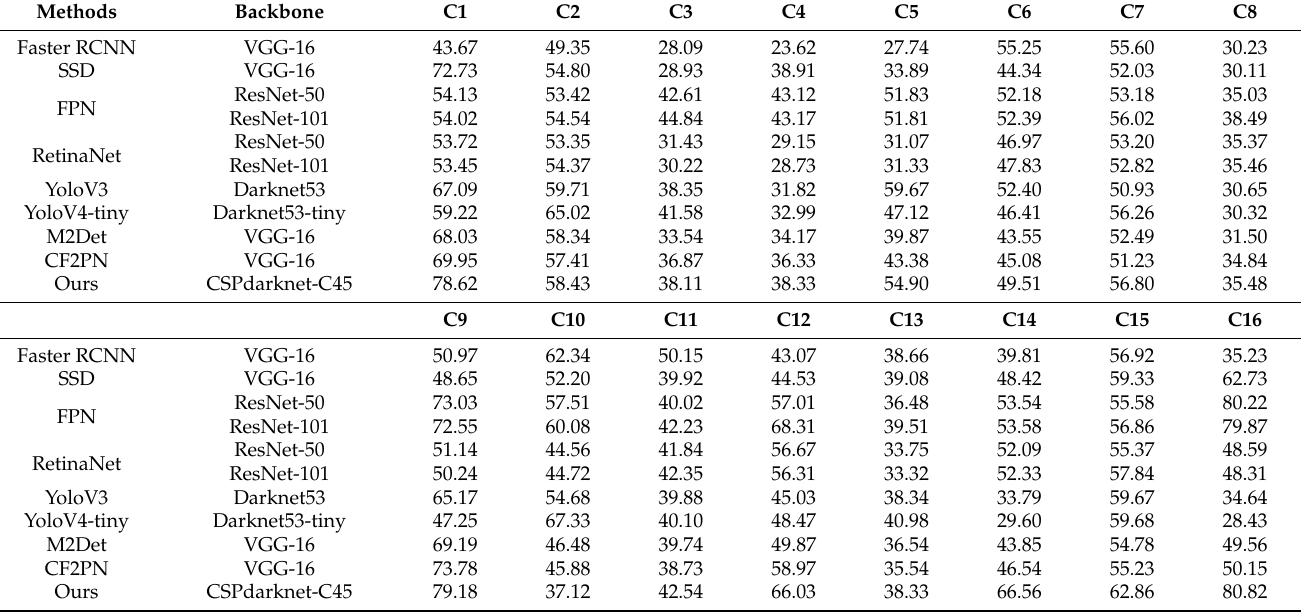
Table 4. Comparison experiments of the AP values for different methods for the DIOR dataset, object class number correspond to Table